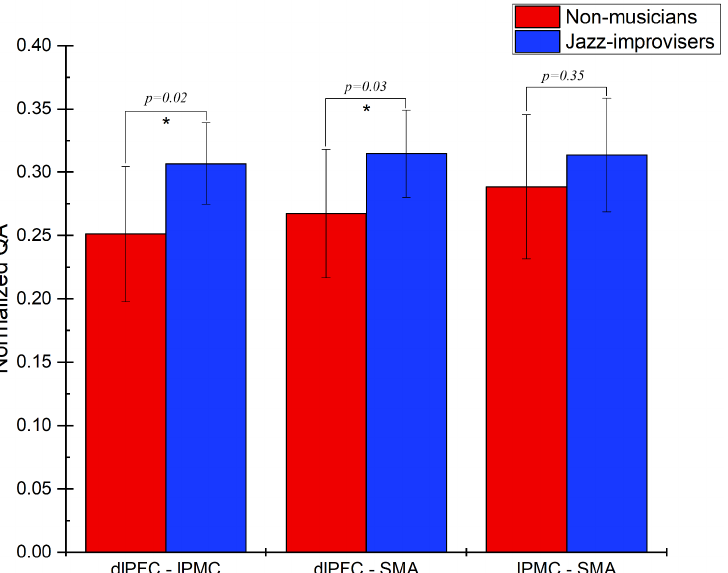
Figure 4. Track-specific normalized quantitative anisotropy (NQA) for advanced jazz improvisers and non-musicians. Advanced jazz improvisers showed significantly higher NQA measures in the prefrontal fiber pathways to the supplementary motor area, represented by a star * a with corresponding p -value.